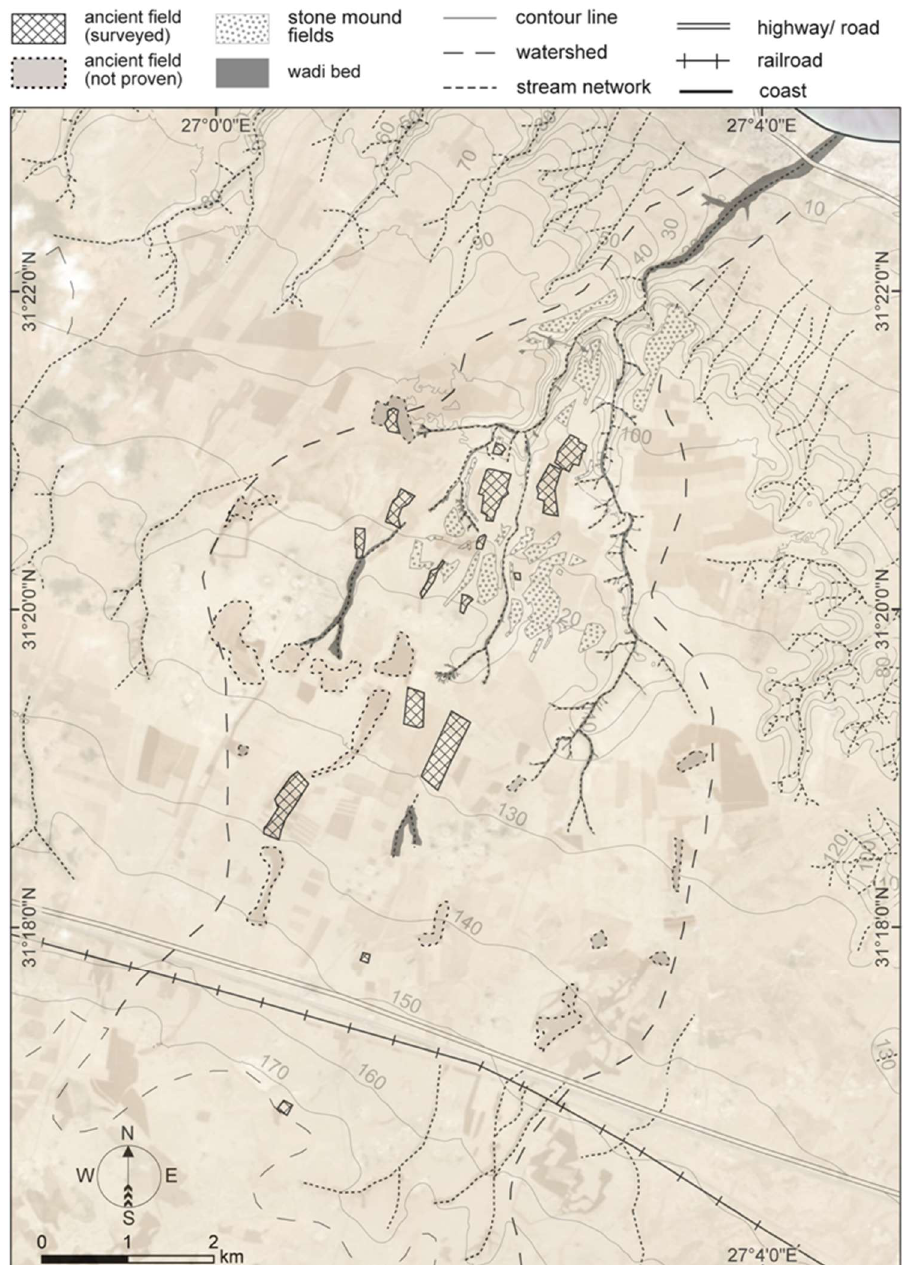
Figure 15. Watershed/drainage system of one wadi (Umm el-Ashdan, cf. Figure 12 for its location west of Marsa Matruh) with the various cultivable areas. Map: A. Nicolay, A.-K. Rieger, T. Vetter.